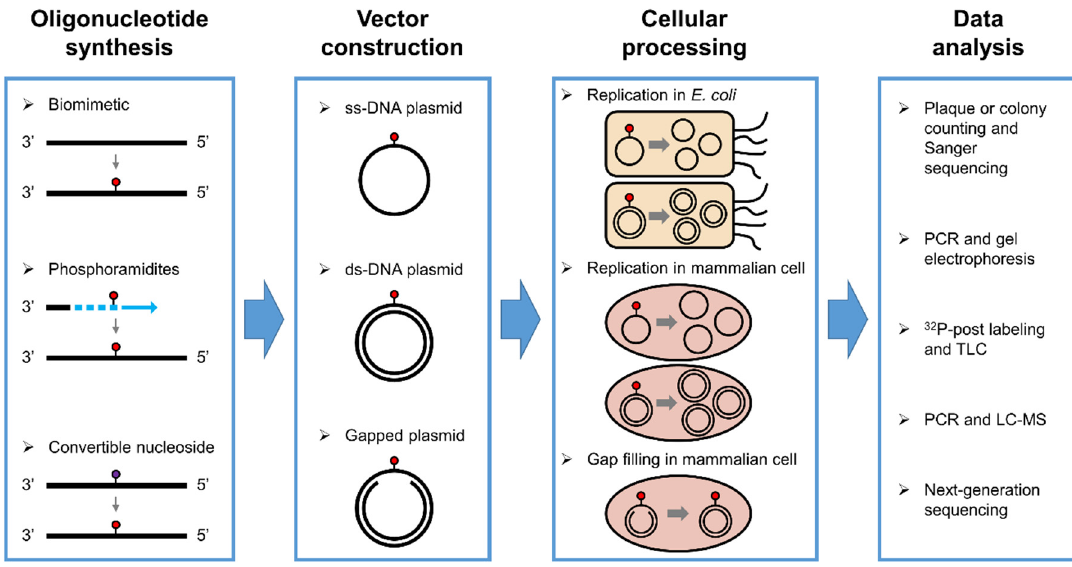
Figure 1. Schematic overview of the shuttle vector-based methods for evaluating DNA biomarkers.